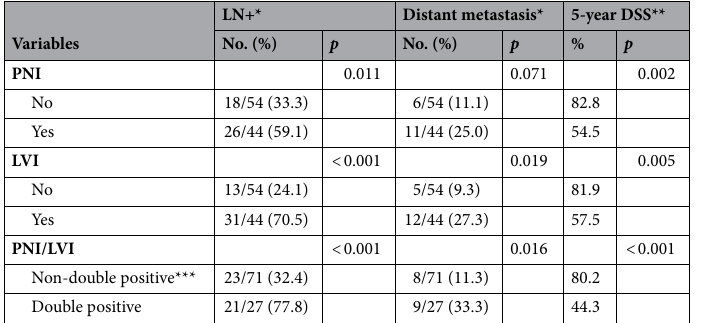
Table 3. Univariate analysis of neck metastasis, distant metastasis, and 5-year DSS. LN + neck metastasis, DSS disease-specific survival, PNI perineural invasion, LVI lymphovascular invasion. *Pearson’s chi-square test or Fisher’s exact test. **Log-rank test. ***Double negative or single positive.